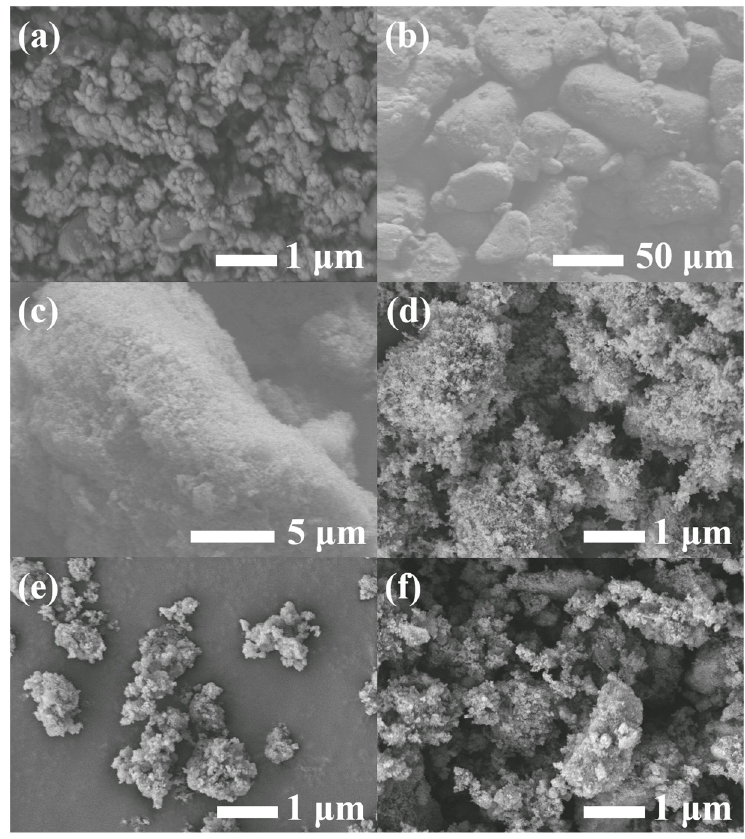
Figure 2. Scanning electron microscope (SEM) images of ( a ) bulk g-C 3 N 4 ; ( b , c ) AHPi; ( d ) CAHPi5; ( e ) CAHPi10 and ( f ) CAHPi20.